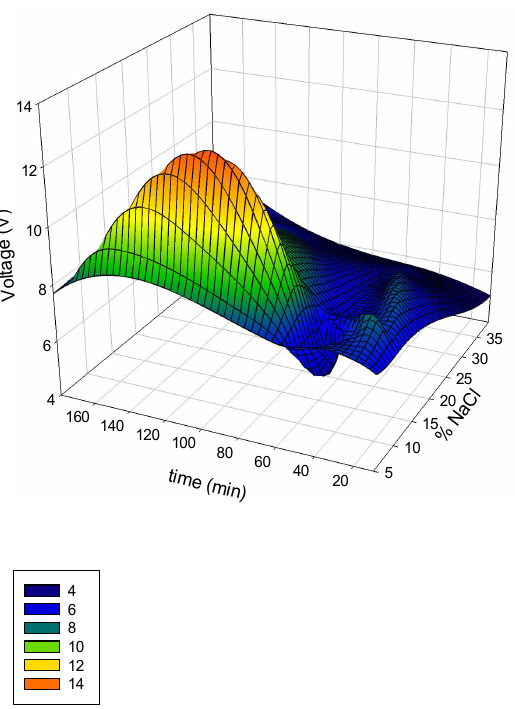
Figure 4. Voltage variation as a function of time and % NaCl in the initial screening.